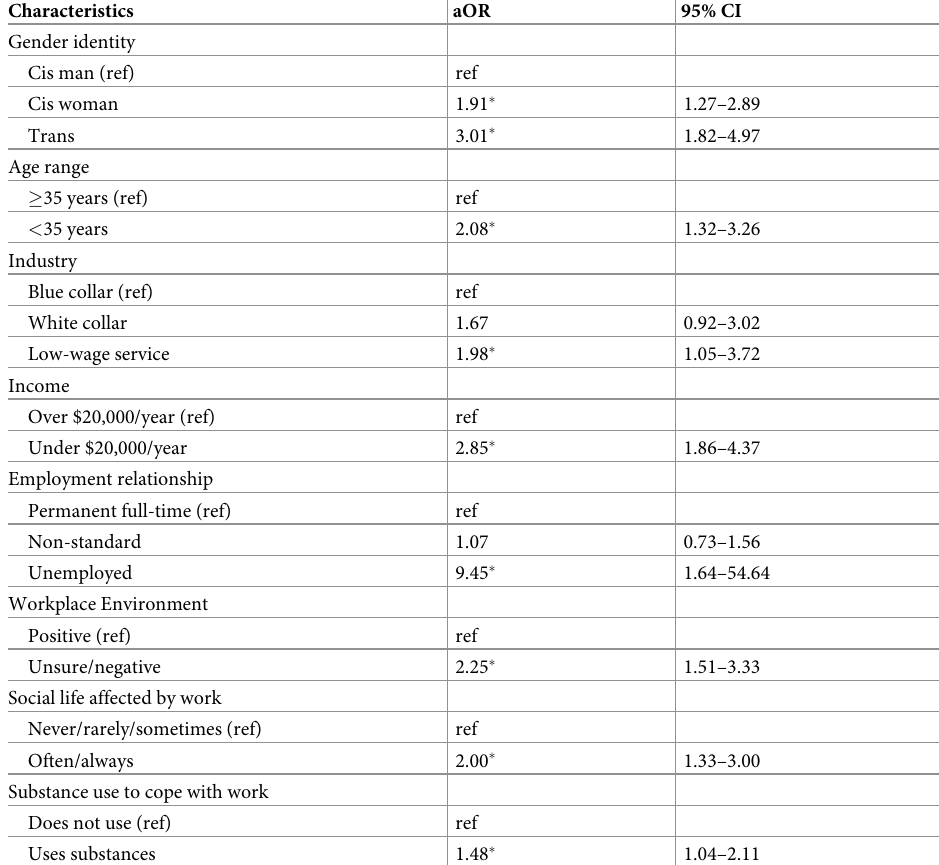
Table 2. Ordered logistic regression estimates of impact of sociodemographic and employment characteristics on LGBTQ workers’ mental health (‘neutral’ and ‘poor’ mental health compared to ‘good’ referent category).